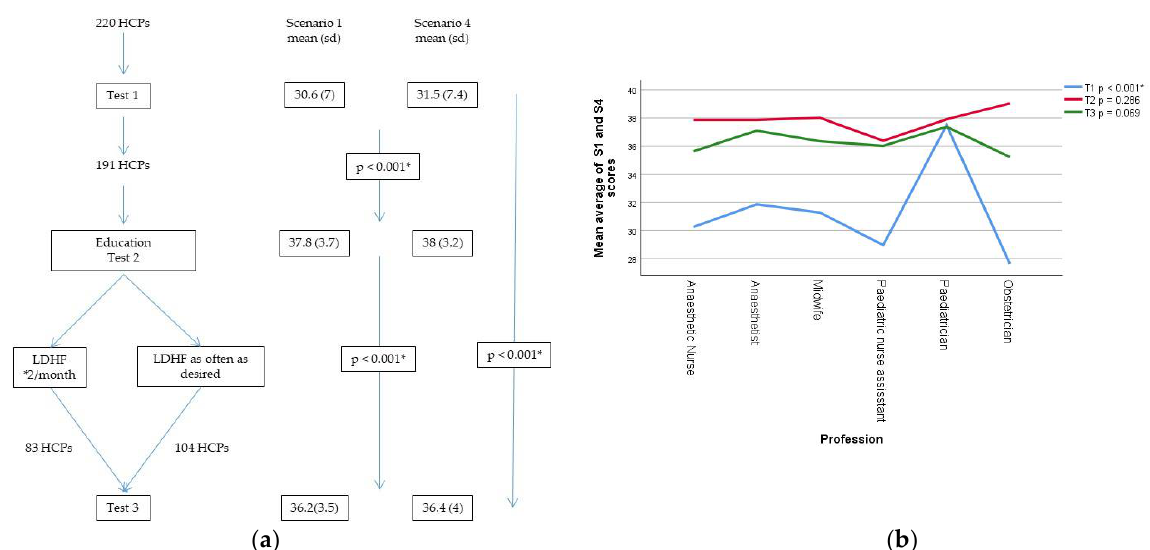
Figure 5. ( a ) Flow diagram of participants through the study with mean (sd) scores for scenario (S)1 and scenario (S)4 of all participants performing each of the three tests; and ( b ) line graph of the professional-group mean of averaged S1 and S4 scores at each test-point. Blue line connects mean T1 scores of the six professional groups, the red and green lines T2 and T3 scores, respectively. HCP = healthcare personnel; LDHF = low-dose high-frequency; * = significant difference in scores at the 0.05 level.